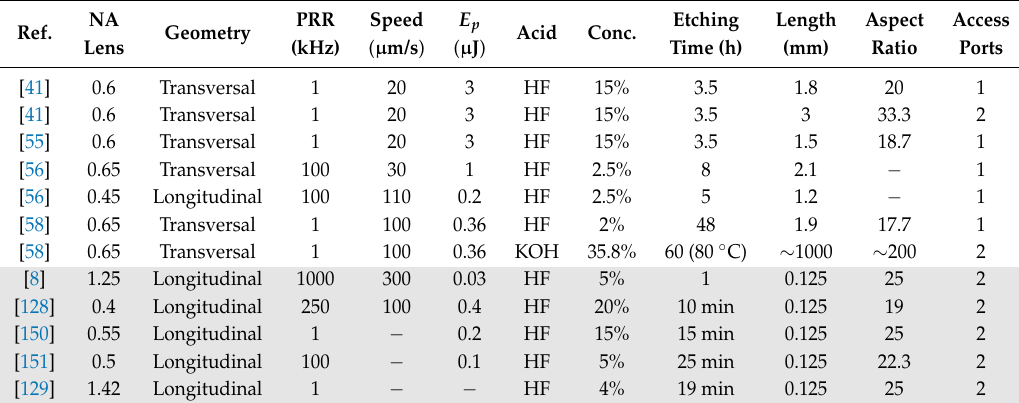
Table 7. fs laser inscription parameters (step 1) and chemical etching properties (step 2) of microfluidic channels in literature. Their length and aspect ratio are indicated. The shaded rows correspond to microchannels in optical